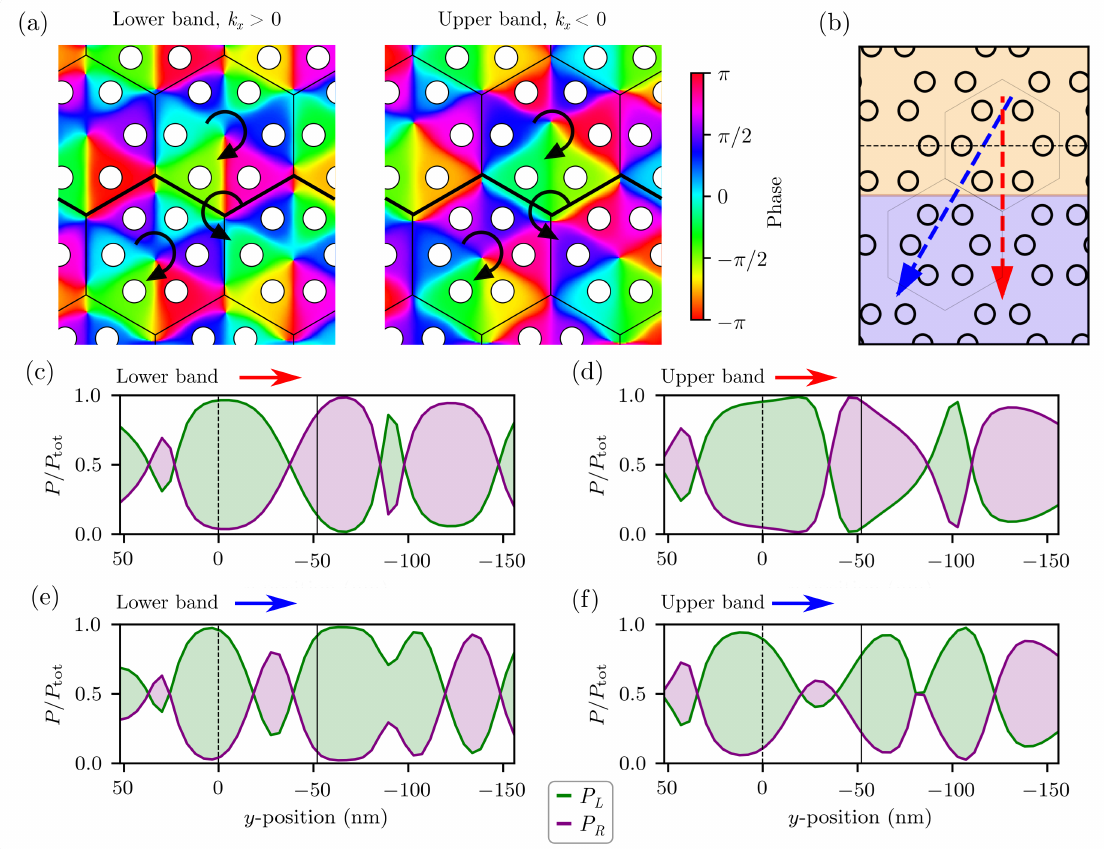
Figure 4. Far field excitations: ( a ) Phase of the z -component of the electric field for edge eigenmodes, in the (left) lower band for k x > 0 and (right) upper band for k x < 0. An incident beam with non-zero orbital angular momentum will couple to the phase vortices (black arrows) of the edge modes. ( b ) A diagram showing the paths of the beam across the interface between expanded (orange) and shrunken (blue) regions. The y -value of the centre of the expanded unit cell is shown as a dotted black line. ( c , d ) Beams along the red path. Fraction of power to the left P L / P tot (green) and right P R / P tot (purple) channels upper band ω = 2.795 eV and the lower band ω = 2.76 eV. Regions are coloured to indicate directionality to the left or right. y -values for the centre of the unit cell (vertical dotted line) and interface (vertical solid line) are highlighted. ( e , f ) Beam along the blue path. Fraction of power to the left and right for lower and upper bands. This path is chosen to maximise